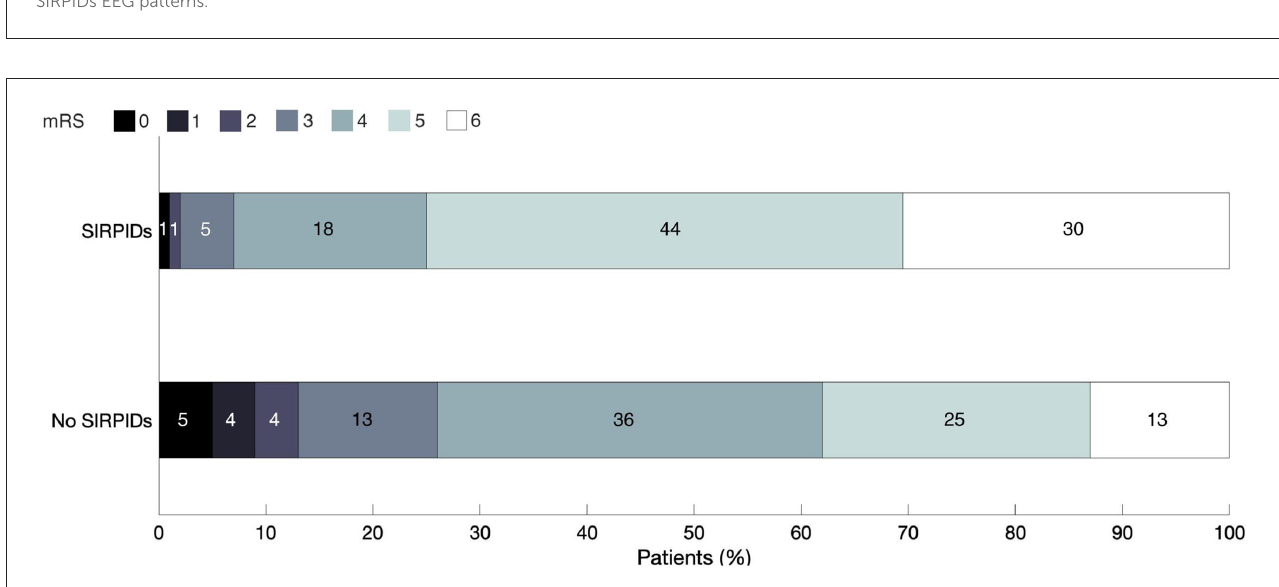
FIGURE2 Distribution of discharge modified Rankin Scale scores across the